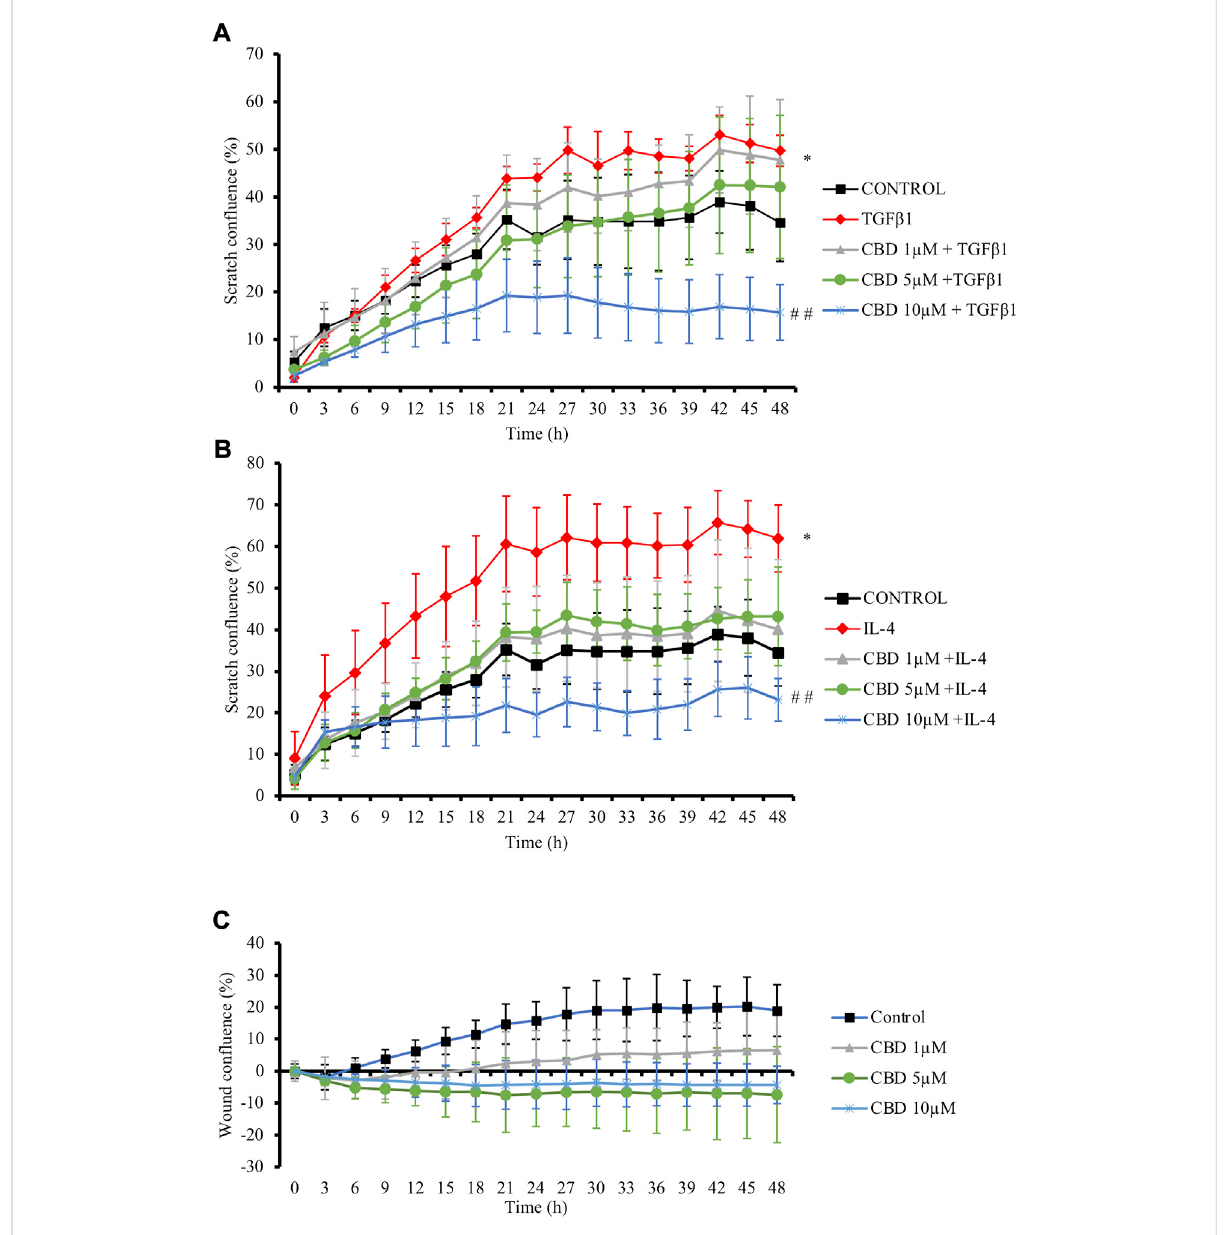
CBD reduces in vitro fi broblast migration. NHDF monolayers were scratched and treated with TGF β 1 (A) or IL-4 (B) in the presence of CBD or with CBD alone (C) . Results are expressed as percentage of closure (con fl uence) ± SD (n = 3). * p < 0.05 versus control; ## p < 0.01 vs TGF β 1-treated